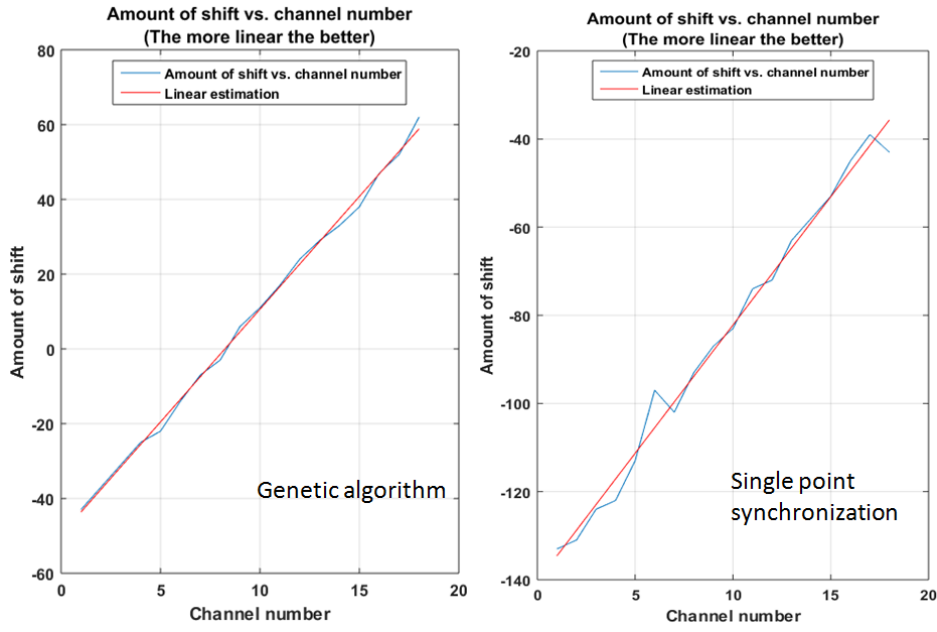
Figure 15. Linearity comparison for the correctly made splice.